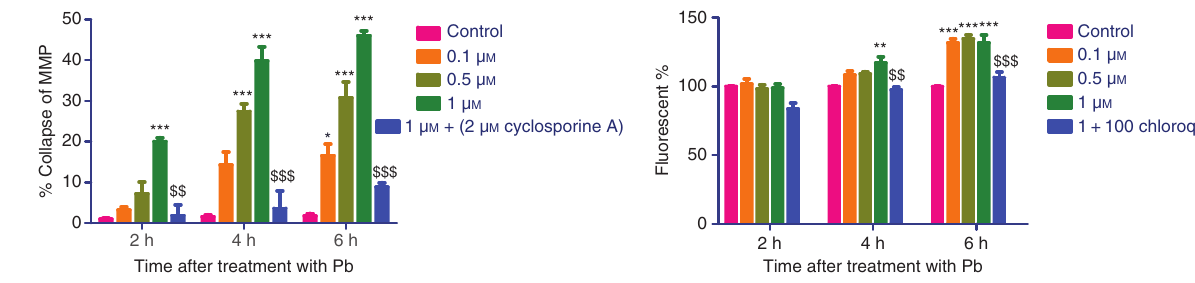
Figure 5: Leakage of lysosomal membranes after loading of acridine orange on